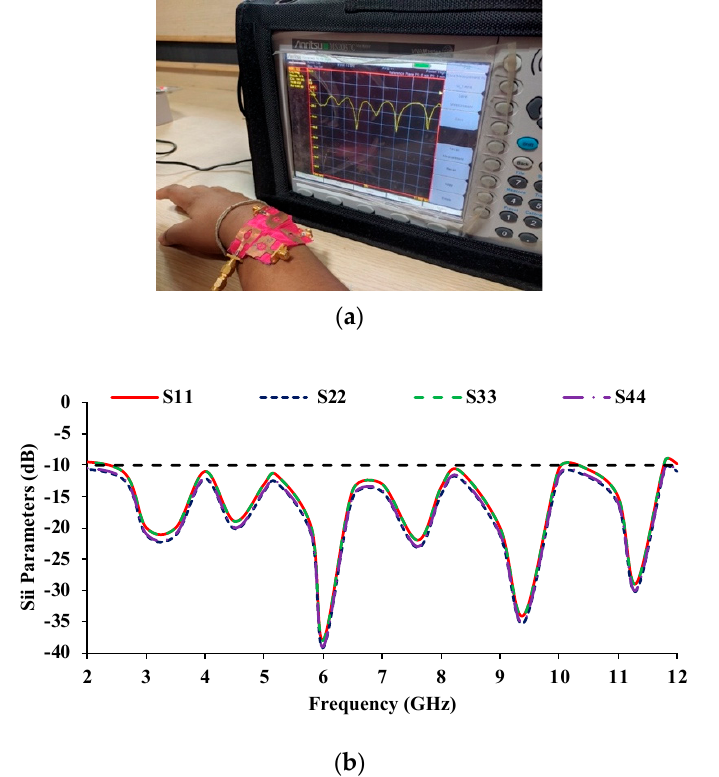
Figure 23. SAR analysis of the MIMO prototype antenna ( a ) VNA measurement, ( b ) Reflection coefficient curves.